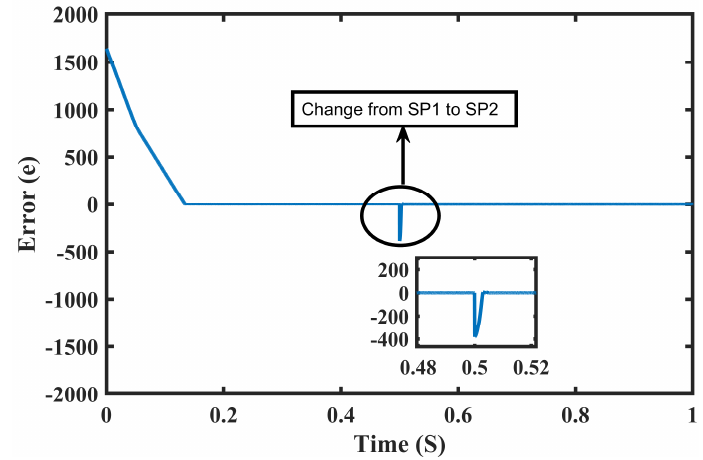
Figure 18. Error in SP1 and SP2.